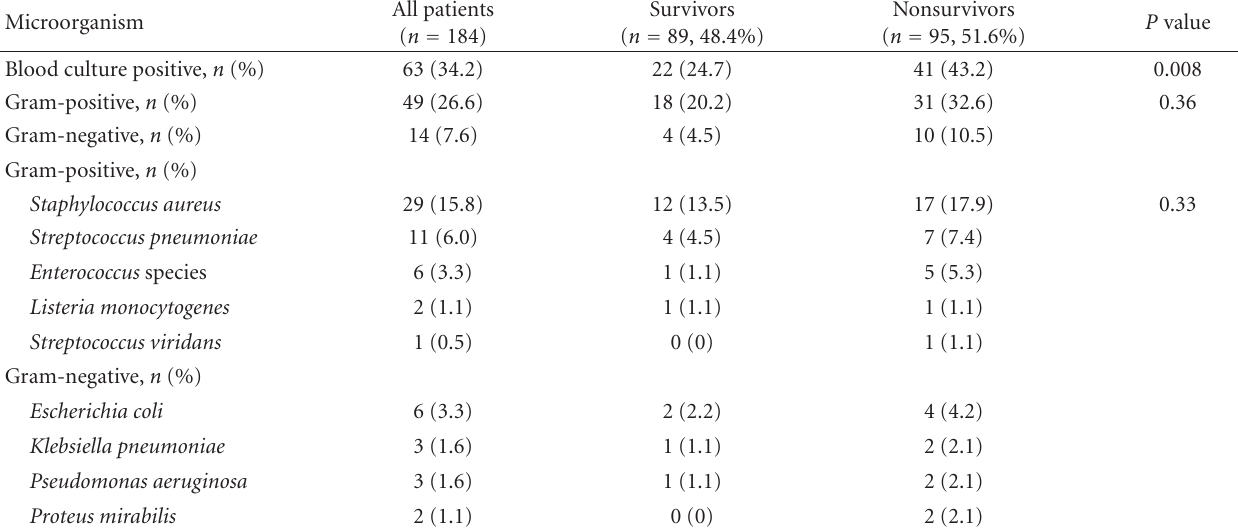
Table 2: Microorganisms isolated from blood cultures in patients with severe sepsis and septic shock according to outcome. Microorganism